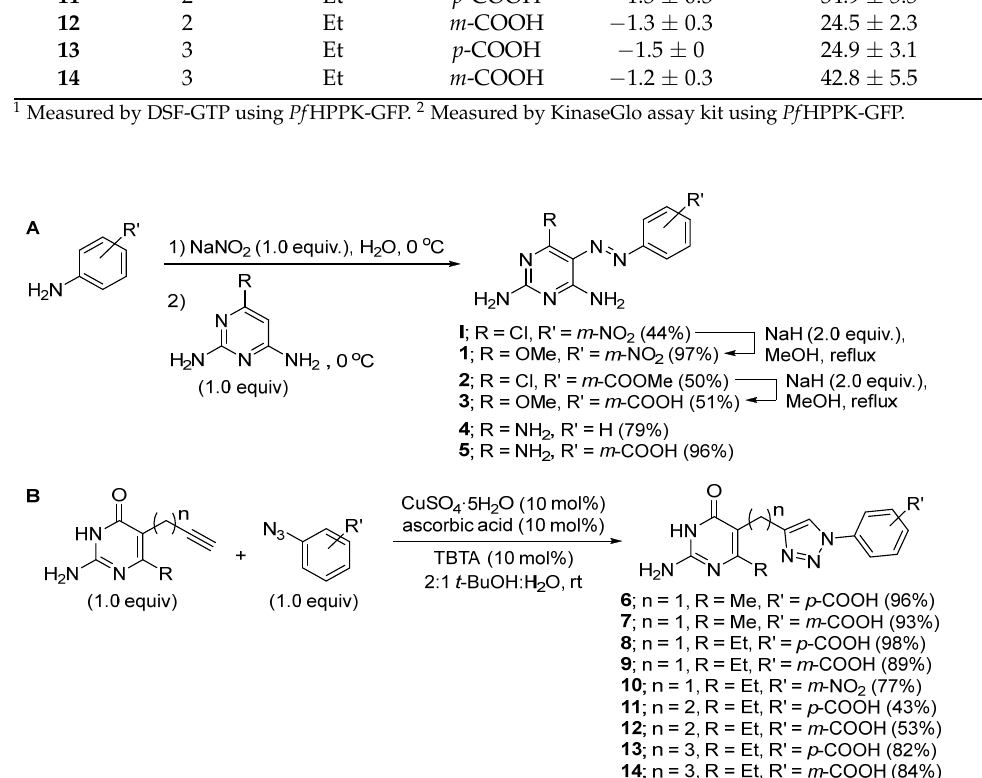
Figure 4. Synthesis of ( A ) 5-phenylazo-2,4-diamino pyrimidine derivatives (series 1); ( B ) phenyltriazolyl-2-amino-4-pyrimidinone analogs (series 2). First, the diazonium coupling between substituted anilines and 2,6-diamino-4- chloropyrimidine or 2,4,6-triaminopyrimidine yielded the corresponding analogs ( I , 2 , 4 , and 5 ) in moderate to excellent yields. Next, nucleophilic aromatic substitution with MeOH mediated by NaH led to the replacement of Cl with OMe ( 1 and 3 ) in good yields.